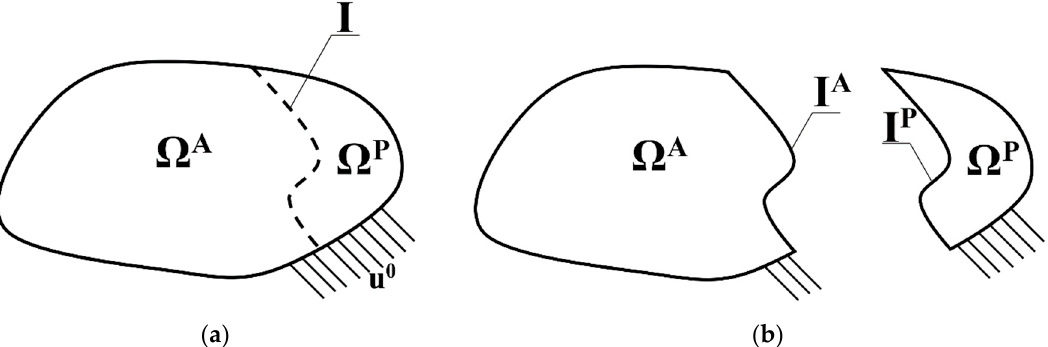
Figure 2. Considered mechanical system: ( a ) idea of the interface between subsystems; ( b ) division for hybrid simulation.